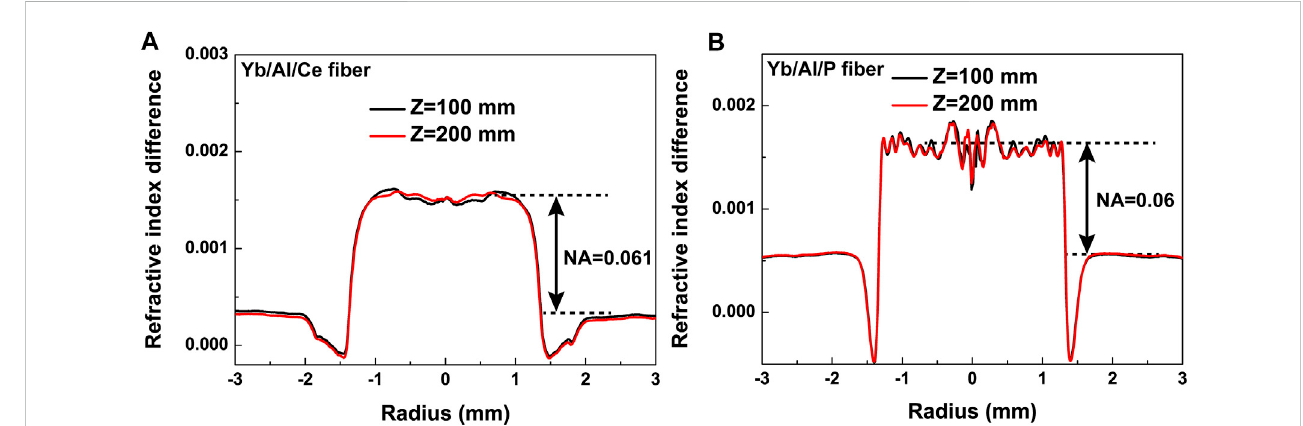
FIGURE 1 Refractive index pro fi les of (A) Yb/Al/Ce co-doped and (B) Yb/Al/P co-doped preforms at the positions of 100 mm and 200 mm along the longitudinal direction.